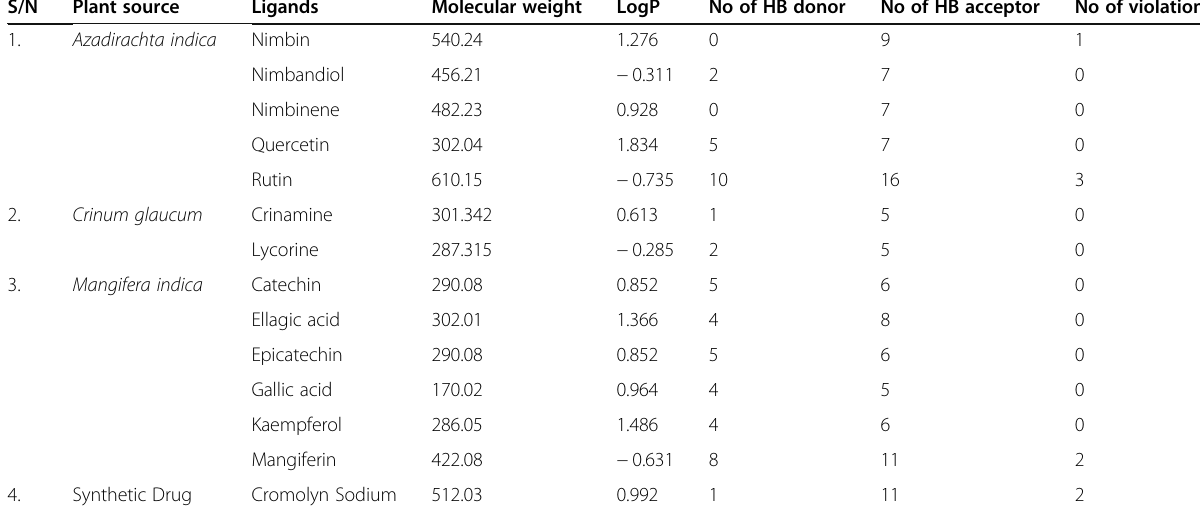
Table 2 Physicochemical properties of compounds calculated based on the Lipinski ’ s rule of 5